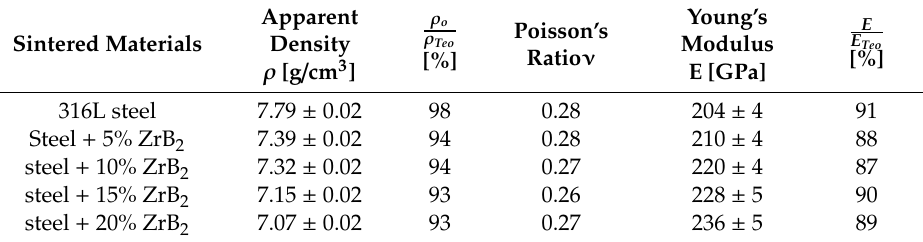
Table 1. The properties of 316L steel and steel–ZrB 2 composites sintered by SPS/FAST method.